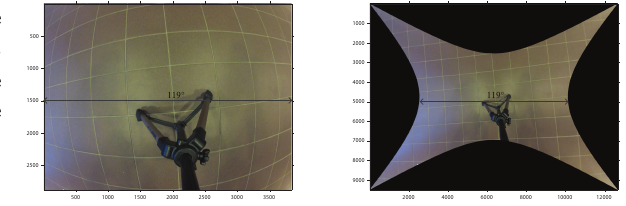
Figure 17: Fisheye calibration